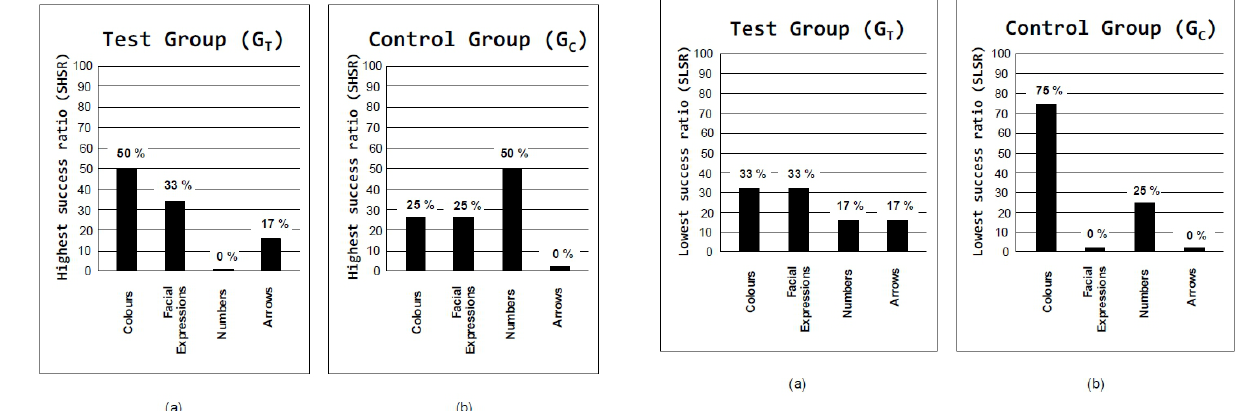
Figure 12. Lowest success ratio (SLSR) for each visual